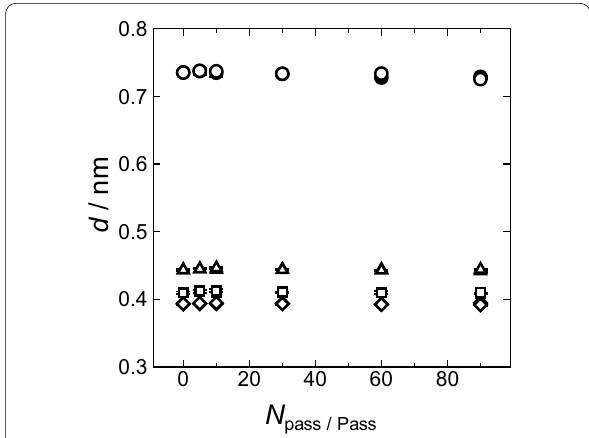
Fig. 4 Relationships between lattice spacing in products and ACC conditions. Diamonds: (2 0 0) plane of U-series;